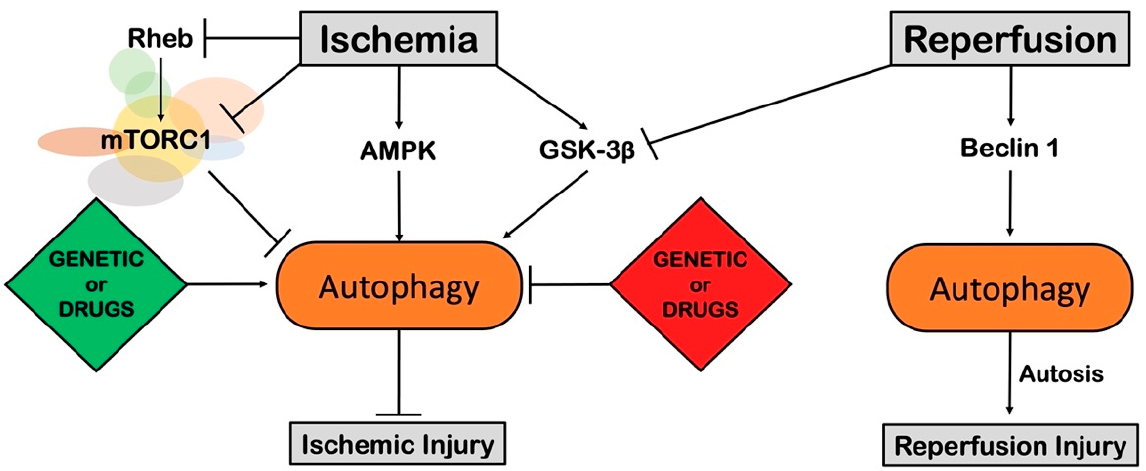
Figure 5. Schematic representation of the role of autophagy in myocardial ischemia. Autophagy activation before and immediately after ischemia limits ischemic injury (left). However, excessive activation of autophagy during reperfusion leads to detrimental effects. AMPK, adenosine monophos- phate (AMP)-activated protein kinase; GSK-3 β , glycogen synthase kinase 3 β ; MST1, mammalian sterile 20-like kinase 1; mTORC1, mammalian target of rapamycin complex 1; Rheb, Ras homolog enriched in brain.